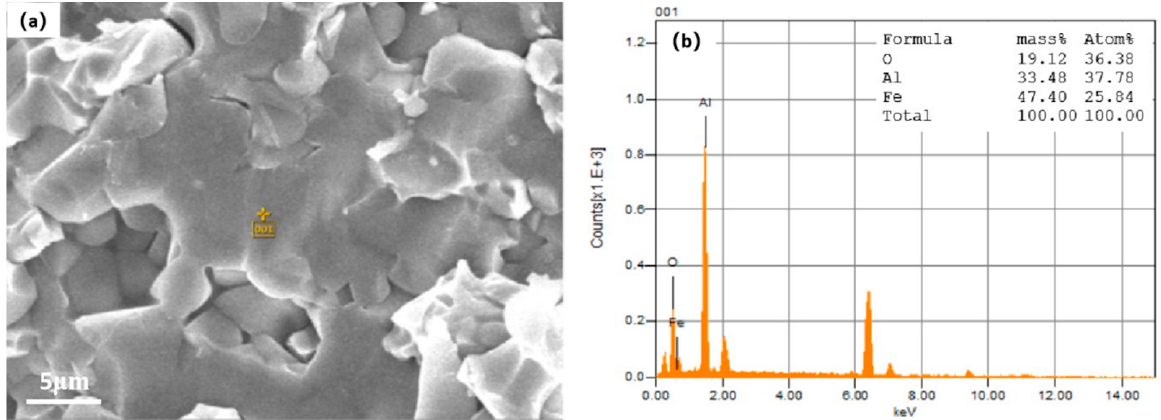
Figure 5. EDS analysis of FeAl 2 O 4 phase with Fe:Fe 2 O 3 :Al 2 O 3 at 6:1:2: ( a ) SEM photographs of S2; ( b ) EDS of point.